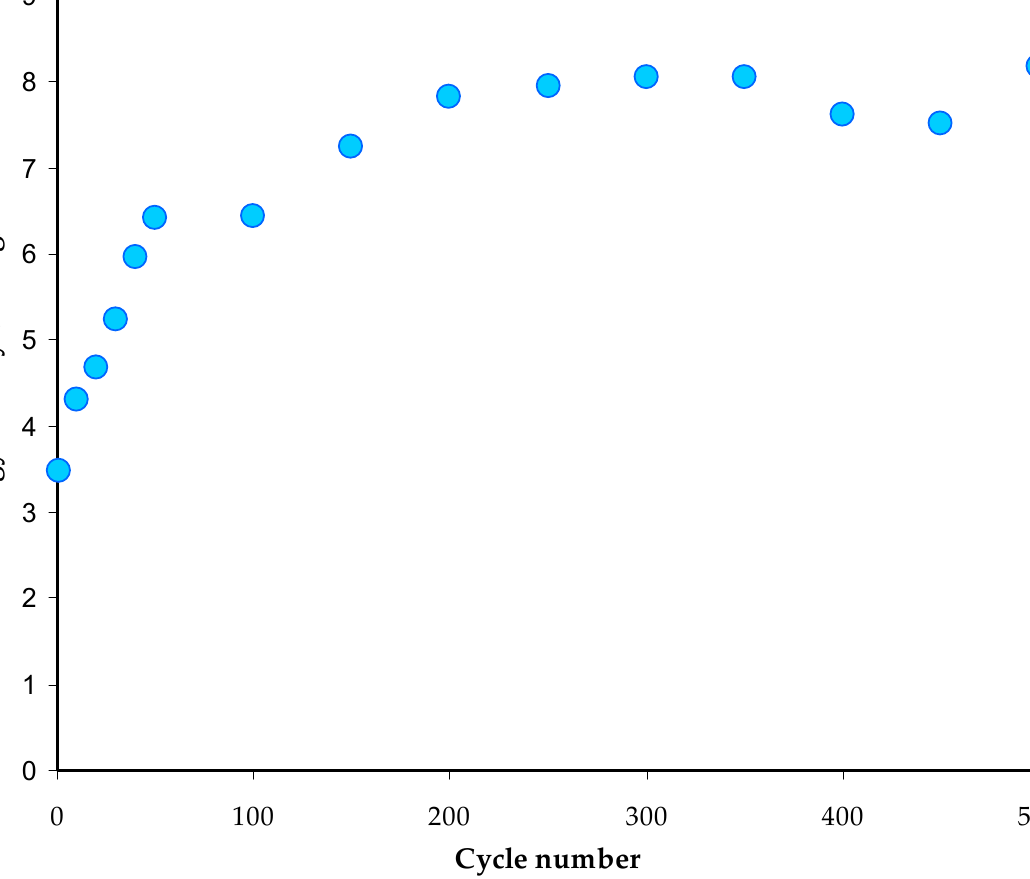
Figure 20. The p trend of the EDLC assembly over 500 cycles. 4. Conclusions The NBG:NaNO 3 :glycerol polymer electrolyte has been prepared byimplementing the solution casting technique. Reductions in bulk resistance with an increase inplasticis- erwere observed. The boost in dielectric constant value with a rise inplasticis- erisevidenceof an increase in free ions, thus increasing the system’s capacitance. The